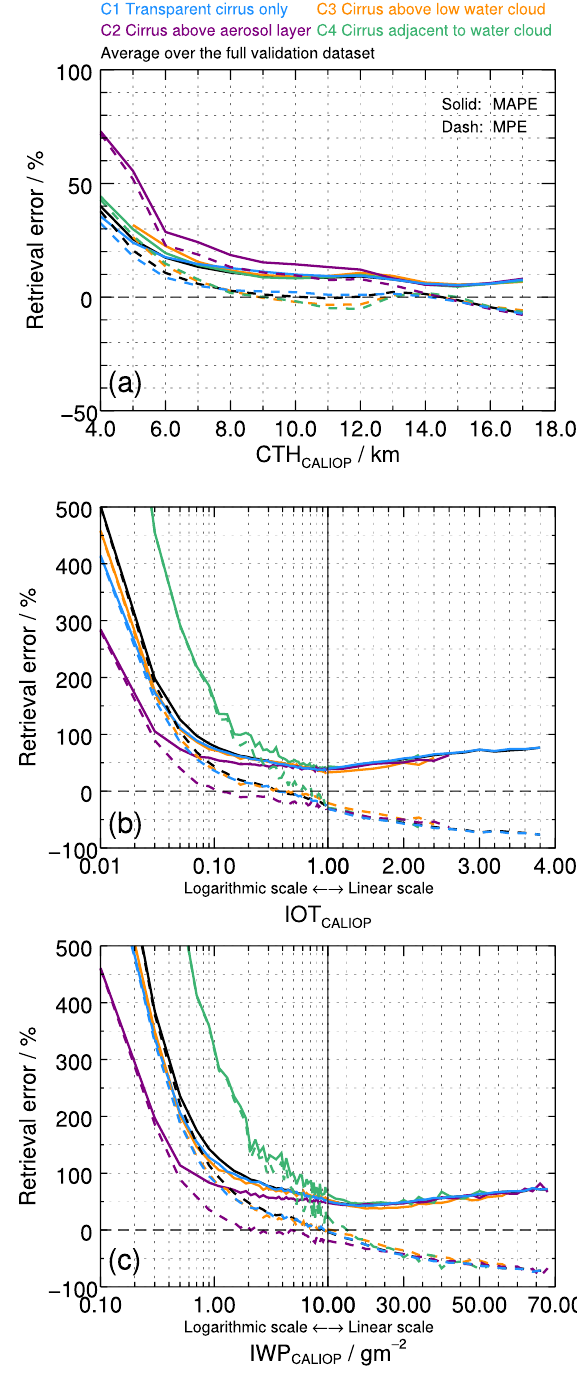
Figure 8. The MAPE (solid) and MPE (dash) of the CTH CiPS (a) , IOT CiPS (b) and IWP CiPS (c) retrievals as functions of the corre- sponding reference retrievals from CALIOP. The retrieval errors of CiPS are presented for the four vertical cloud–aerosol structure classes C1–C4 (see Sect. 4.4.1), representing common cloud remote sensing situations, as well as the average retrieval errors for the full collocation